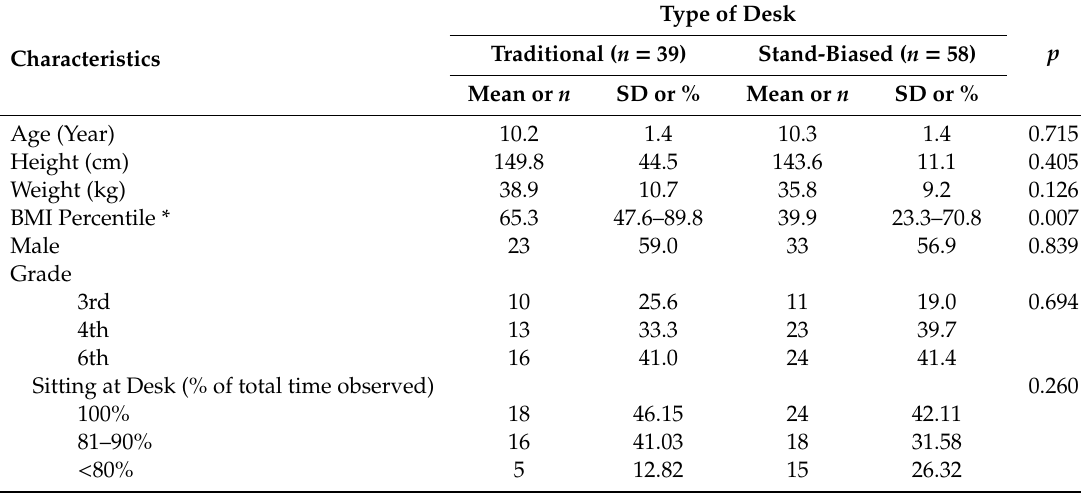
Table 2. Demographic Characteristics of Consented Participants at Baseline.